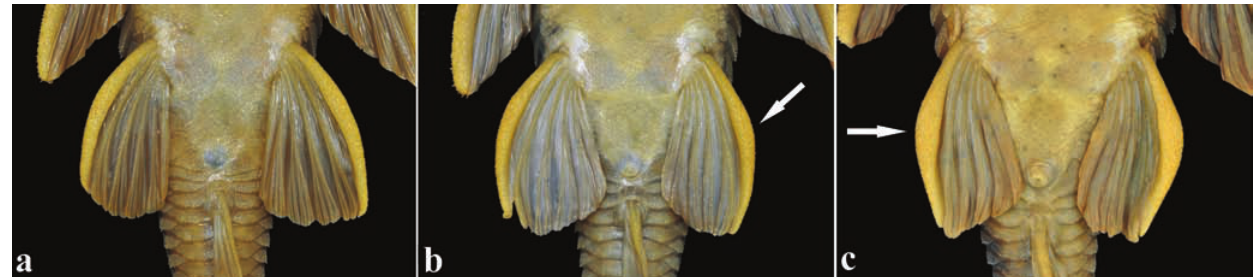
Fig. 12. Sexual dimorphism of Hypostomus basilisko ; (a) MNRJ 40184, paratype, 162.3 mm SL, showing pelvic-fin spine with no tumescence in adult female; (b) MNRJ 40184, paratype, 149.1 mm SL, showing a weakly developed tumescence (indicated by arrow) in juvenile male; (c) MZUSP 111110, holotype, 182.5 mm SL, showing well-developed tumescence (indicated by arrow) in adult